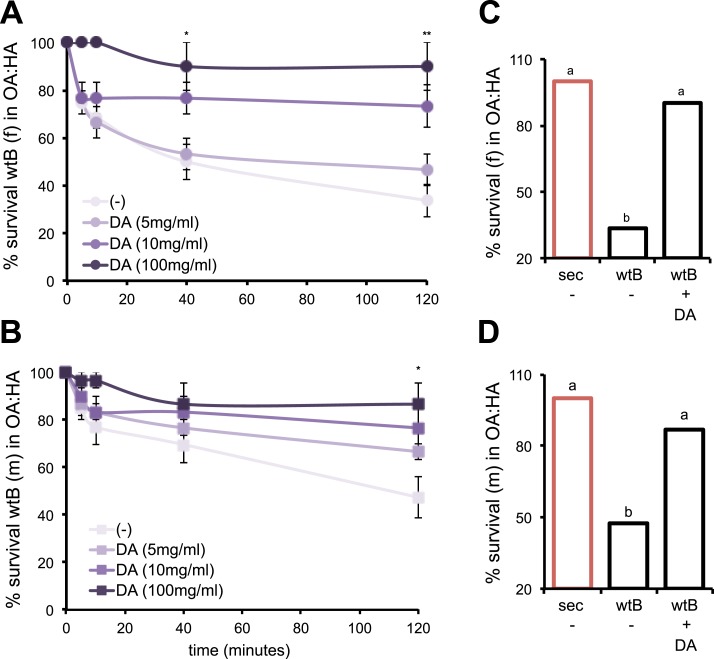
DA contributes to the behavioral resistance to morinda carboxylic acids.(A–B) Survival kinetic curves for D. melanogaster wild-type Berlin (wtB) (A) females (f, N > 3) and (B) males (m, N > 3) exposed to morinda carboxylic acids (OA:HA) and fed a standard diet supplemented with either no (−), or increasing doses of DA (5 mg/ml, 10 mg/ml and 100 mg/ml). *p < 0.02 and **p < 0.002 using Student's t test. (C–D) Survival (%) (N > 3) of D. sechellia (14021–0248.25, sec) and D. melanogaster wild-type Berlin (wtB) (C) females (f) and (D) males (m), fed a non-supplemented (−) or DA (+DA, 100 mg/ml) supplemented standard diet upon 2 hr exposure to morinda carboxylic acids (OA:HA). Different letters denote significant differences (p < 0.01) using ANOVA followed by Tukey's test. Error bars represent s.e.m.